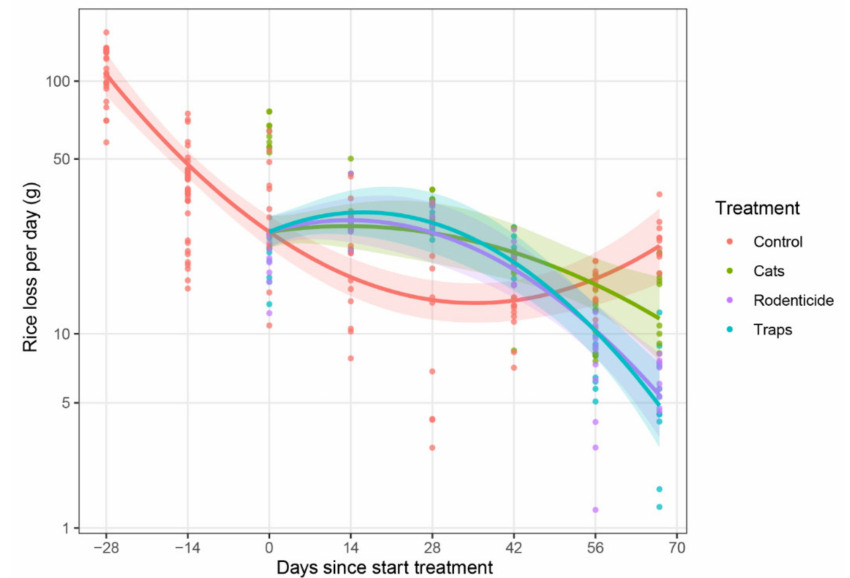
Figure 6. Rice loss by rodents per day from baskets of rice in farmer stores during the wet season of 2016. Estimated time trend lines for each treatment were generated by a mixed model (see Section 2.6), with shaded areas representing 95% confidence bands, indicating that treatments had an e ff ect on reducing rodent losses compared to the untreated control by the end of the storage